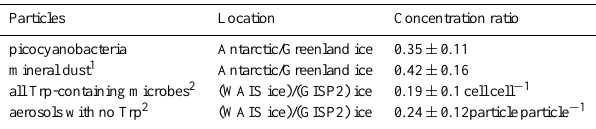
Table 1. Concentrations of picocyanobacteria, dust, microbial cells and non-cellular aerosols in Antarctic relative to Greenland ice Particles Location Concentration